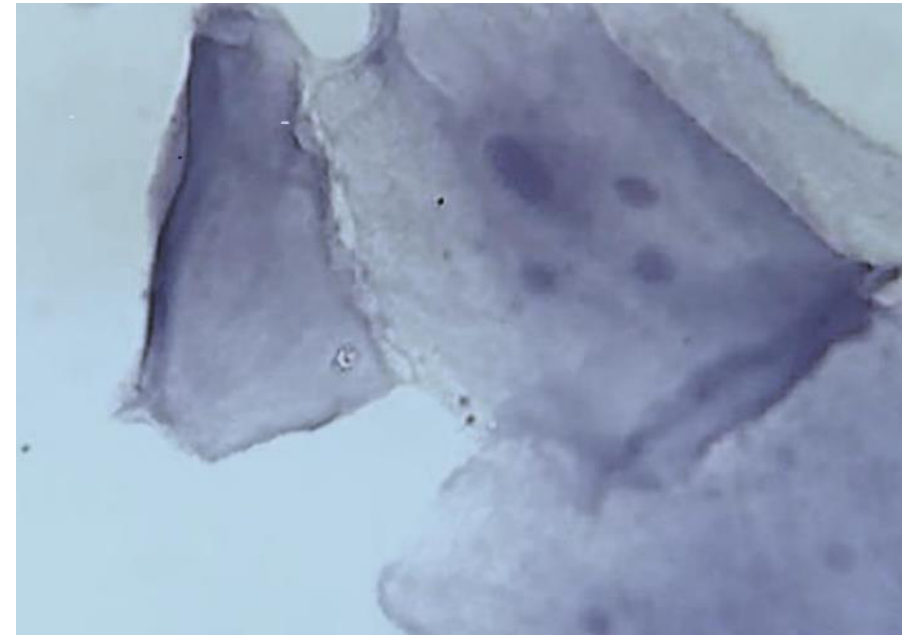
Fig. 1. Micronuclei in buccal mucosa smear of waterpipe smoker (× 1000, Feulgen